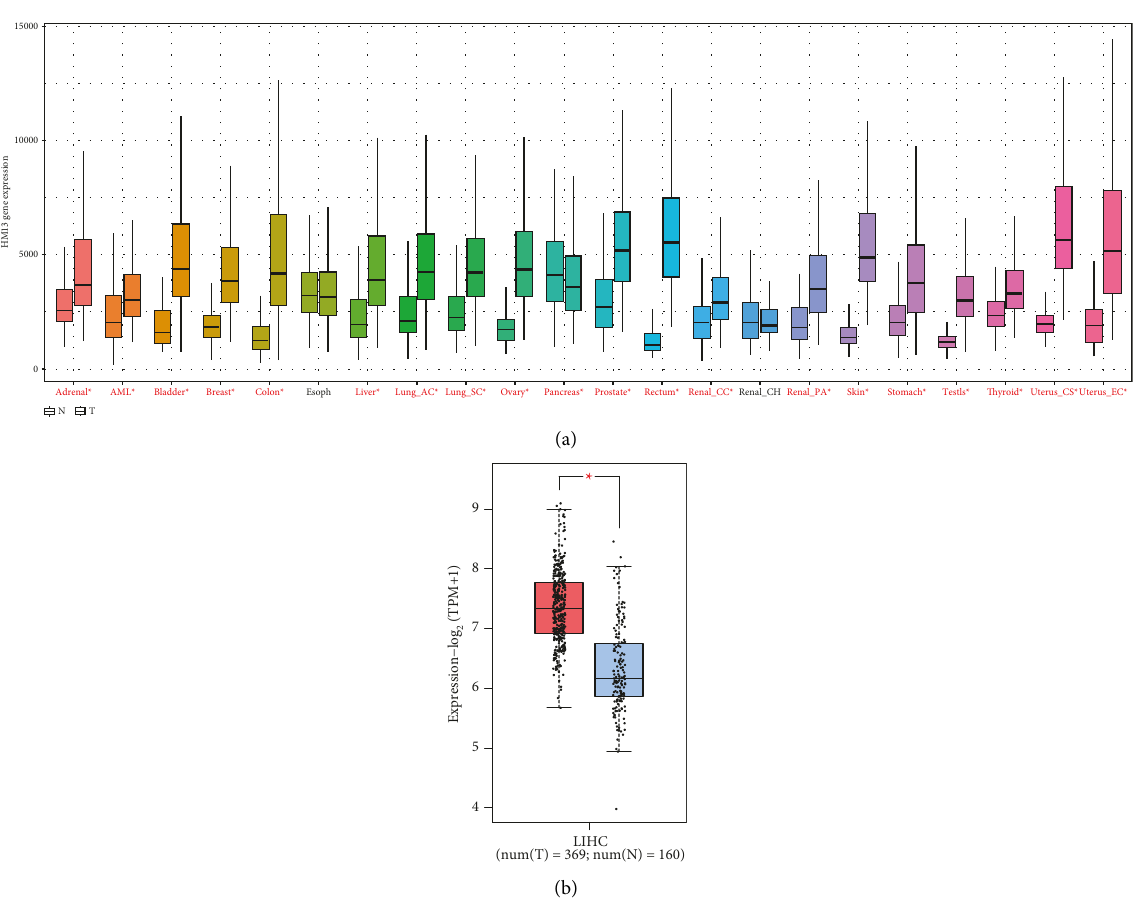
Figure 1: Comparison of HM13 expression in the tissues of carcinoma and normal. (a) Analysis of HM13 expression in different cancer. (b) Highly expressed HM13 was shown in LIHC tissues. ( ∗ P < 0 .